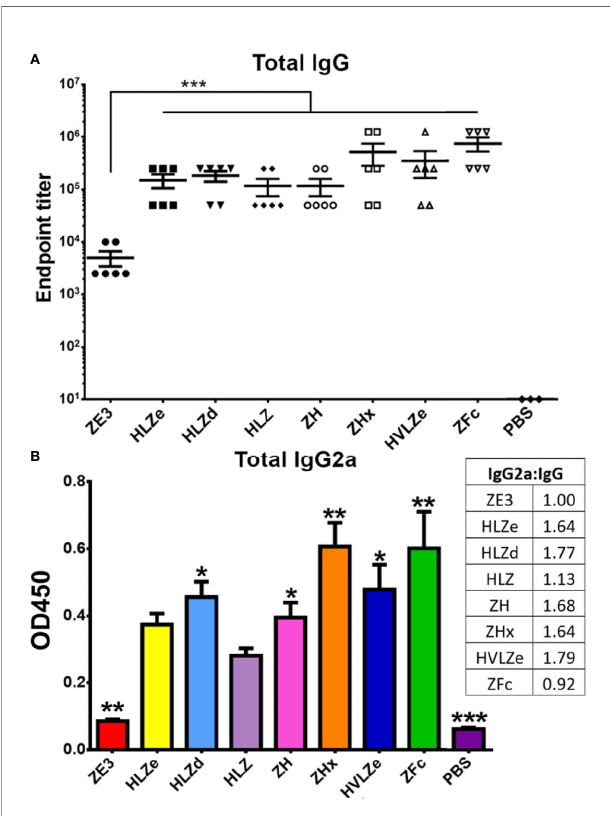
FIGURE 6 | Mouse immunization and serum titers. BALB/c mice (6 per group) were immunized twice two weeks apart subcutaneously with a dose that would deliver 8 m g ZE3 for each IgG fusion or with PBS as a control. Mouse serum samples were collected two weeks after the fi nal dose (A) . Serially diluted mouse serum was analyzed for total IgG production by ELISA. The endpoint was taken as the reciprocal of the greatest dilution that gave an OD 450 reading at least twice the background. Two stars (**) indicates p < 0.01 by one-way ANOVA comparing the indicated columns to ZE3 (B) . Mouse serum samples were diluted 1:100 and analyzed for IgG2a production by ELISA. The table shows the ratio of IgG2a to total IgG for each group, calculated as relative to ZE3, with the ZE3 value set arbitrarily at 1.0. Values with one star (*) indicates p < 0.05 and (**) indicates p < 0.01 by one-way ANOVA comparing the indicated columns to HLZ. Three stars (***) indicates p <